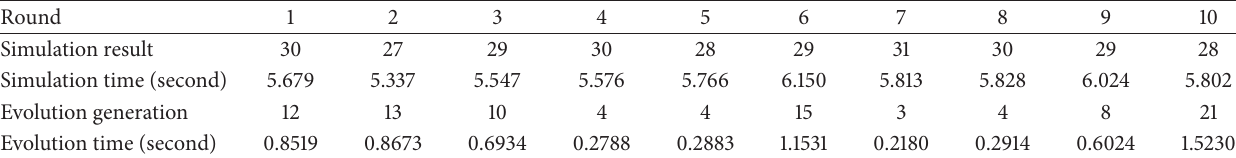
Table 7: The simulation results of ten rounds of experiments of QGA.